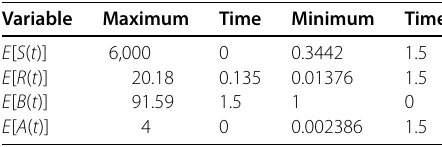
Table 4 Extremum values of the expected values Variable Maximum Time